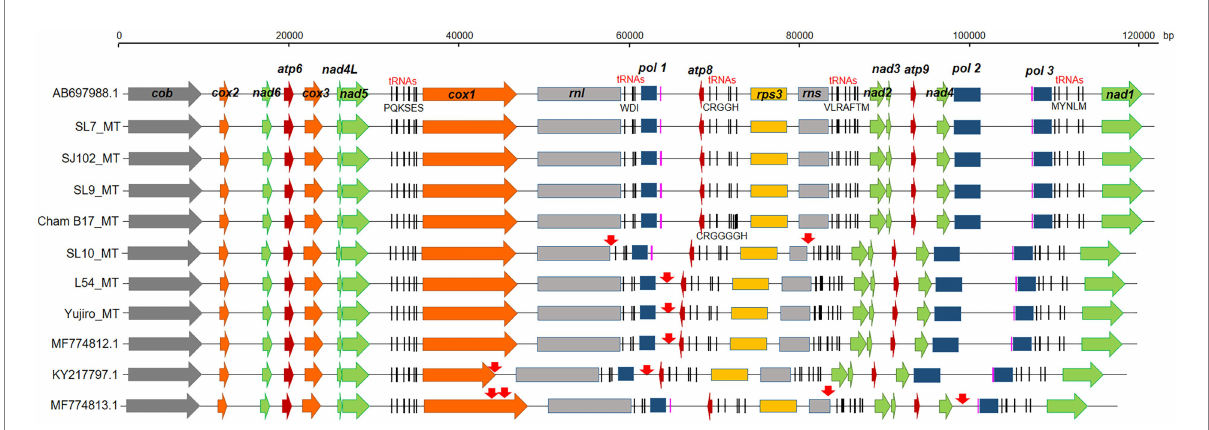
FIGURE 2 Gene arrangement of selected mtDNAs in different strains of Lentinula edodes . The mtDNA genes were annotated by MFannot. Regions of sequence variations are indicated by red arrows. Capital letters under the five tRNA regions indicate tRNAs having anticodons for corresponding amino acids. Two predicted tRNAs with unknown isotypes are colored in